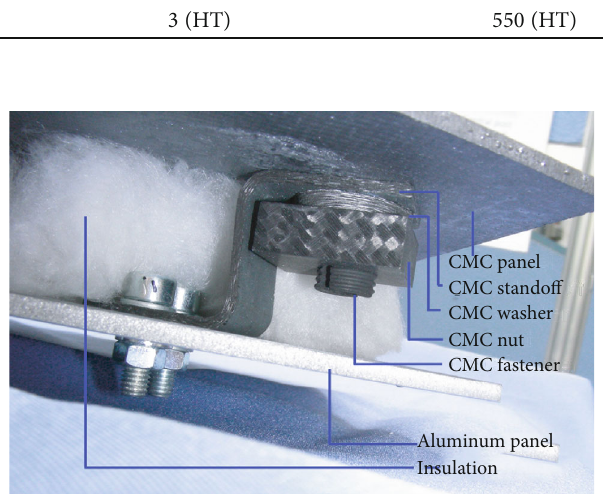
Figure 5: SHEFEX II thermal protection system set-ups [31].